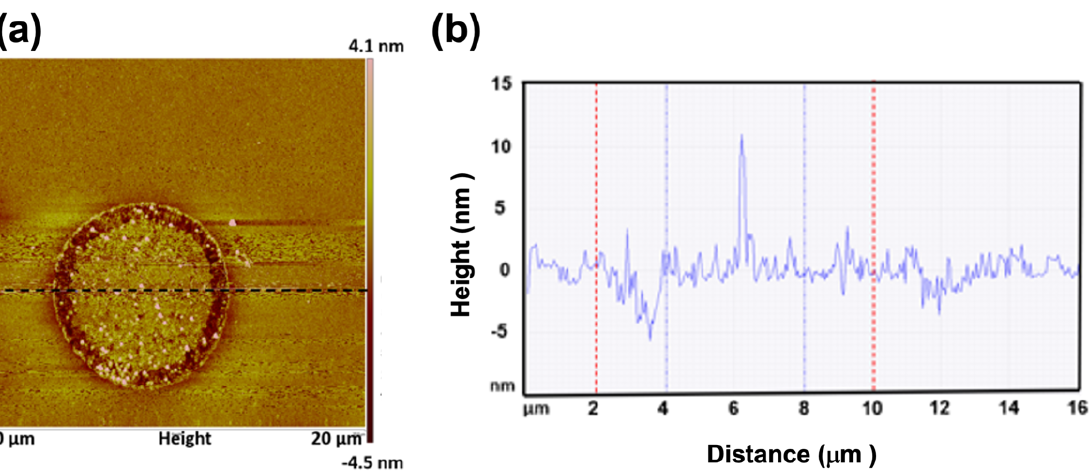
Figure 4. ( a ) AFM topography and ( b ) the results of analyzed surface roughness show that the recess of a typical Cu bump is less than 3 nm and Rq is less than 2